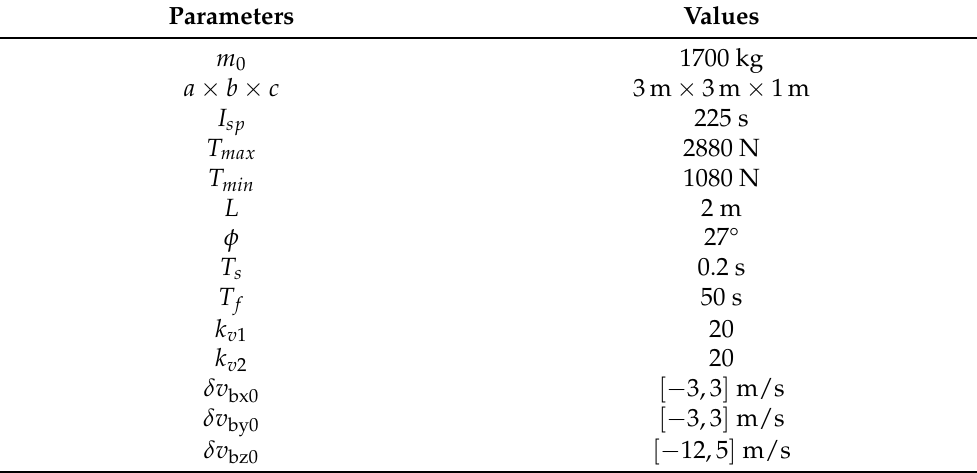
Table 1. Parameter settings of